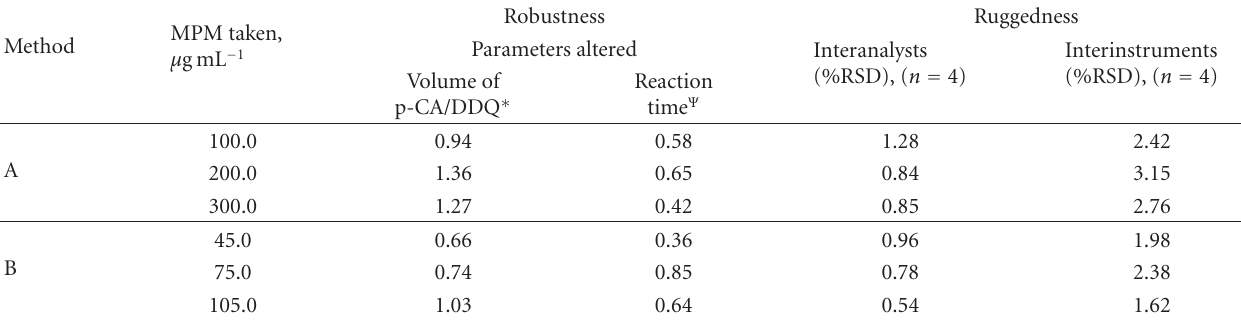
Table 3: Method robustness and ruggedness expressed as intermediate precision